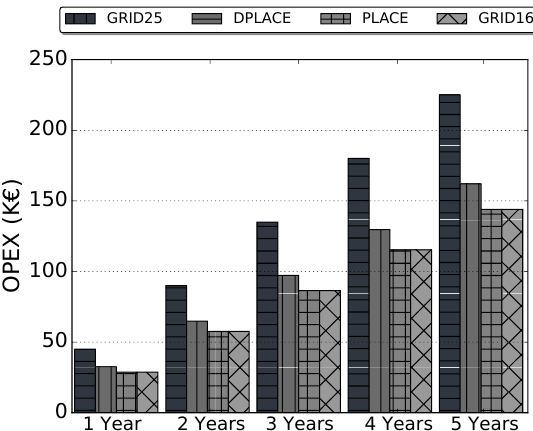
Figure 7. OPEX for analyzed LoRaWAN gateway placement models.